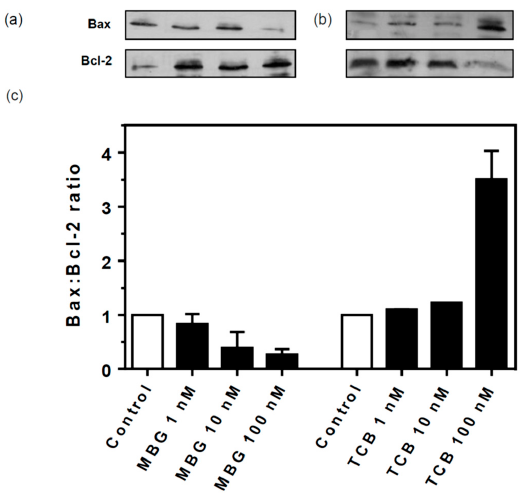
Figure 4. Bax and Bcl-2 expression in LLC-PK1 cells treated with marinobufagin (MBG) and telocinobufagin (TCB). Serum-starved LLC-PK1 cells were treated with 1, 10, and 100 nM MBG and TCB in 2.5% FBS for 72 h. Representative western blots of the pro-apoptotic Bax and anti-apoptotic Bcl-2 for MBG ( a ) and TCB ( b ) and the ratio of the relative optical density quantification for Bax:Bcl-2 ( c ). Data are the mean ± SEM of two independent